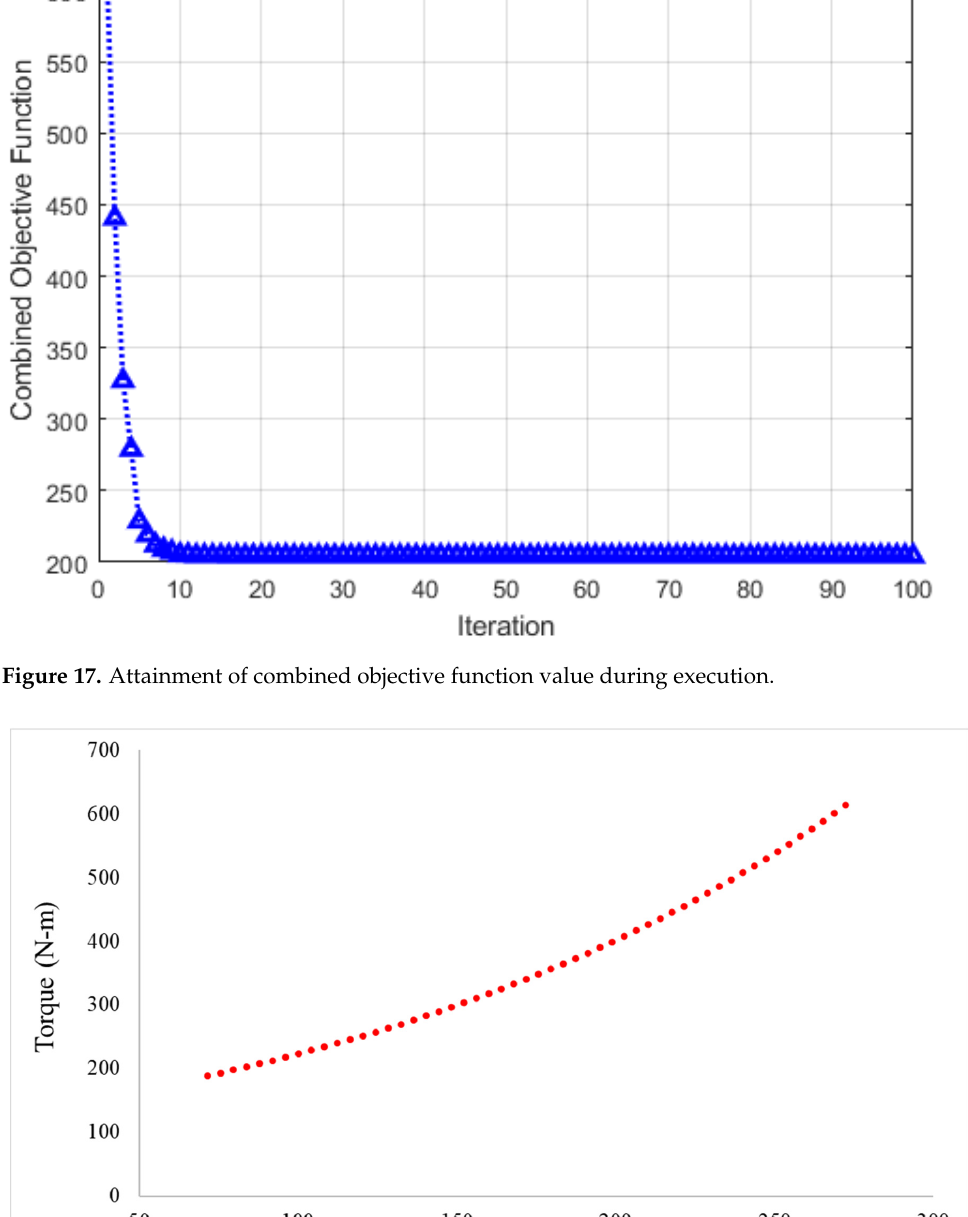
Figure 18. Pareto optimal